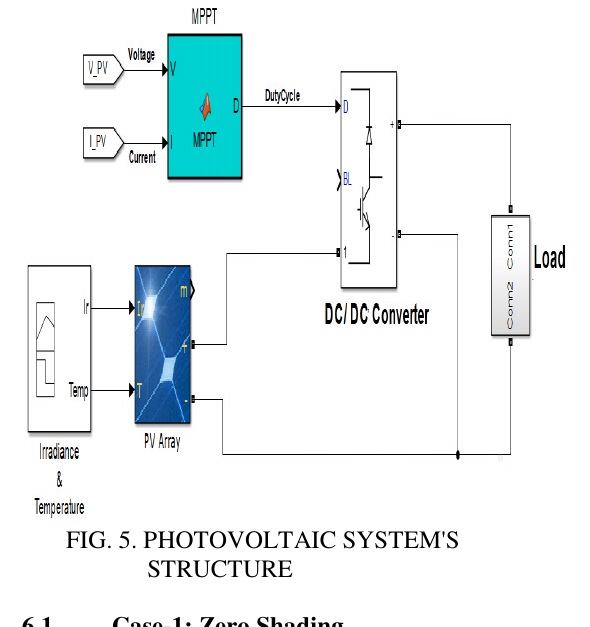
FIG. 5. PHOTOVOLTAIC